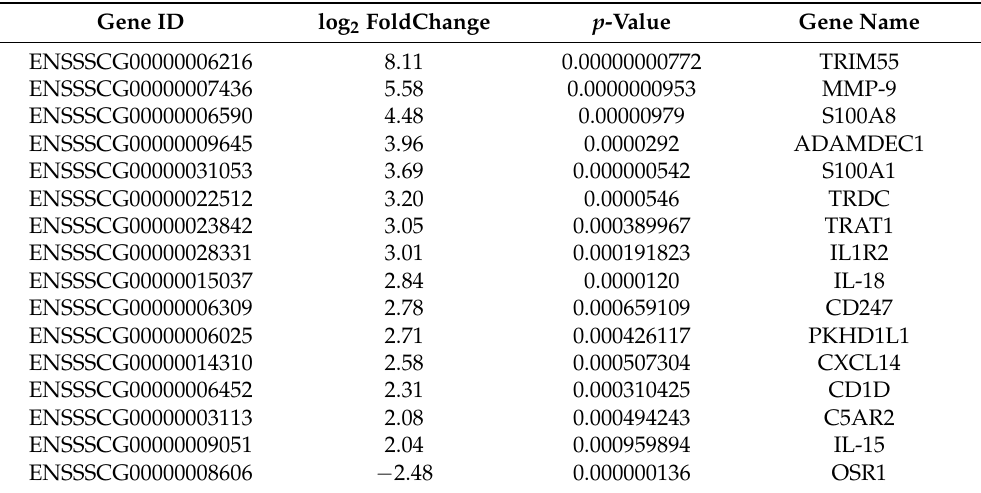
Table 2. Differentially expressed genes (DEGs) while comparing contralateral femoral artery with AVF femoral artery combining all tissues (+value = higher expression in AVF FA; − value = higher expression in contralateral FA).